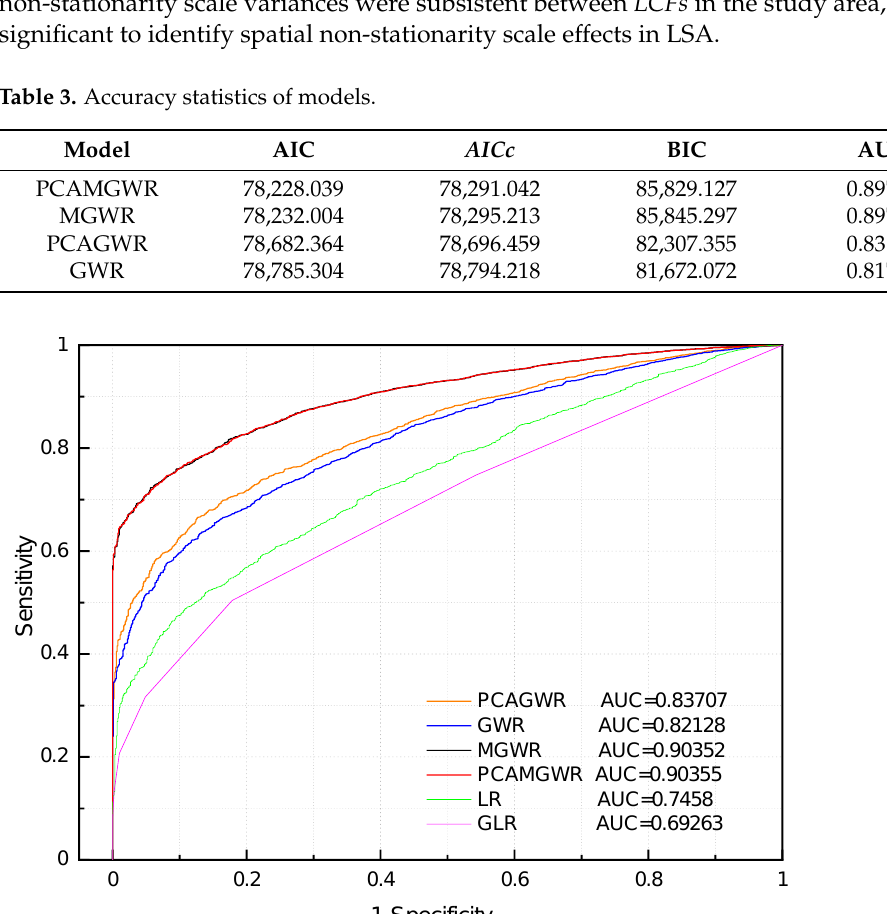
Figure 14. Parameter variation diagram of bandwidth judgment criterion: ( a ) SOC-f for MGWR and PCAMGWR, ( b ) AICc for GWR and PCAGWR. 6. Discussion Landslides are a major geohazard, causing casualties and economic losses. Therefore, it is necessary to establish a suitable model to assess landslide susceptibility and make a landslide zoning map. The assessment methods and models of landslide susceptibility have been discussed in many studies. For example, a comparative study of WOE, AHP, ANN, and GLR procedures for landslide susceptibility zonation is presented in [69] . WOE